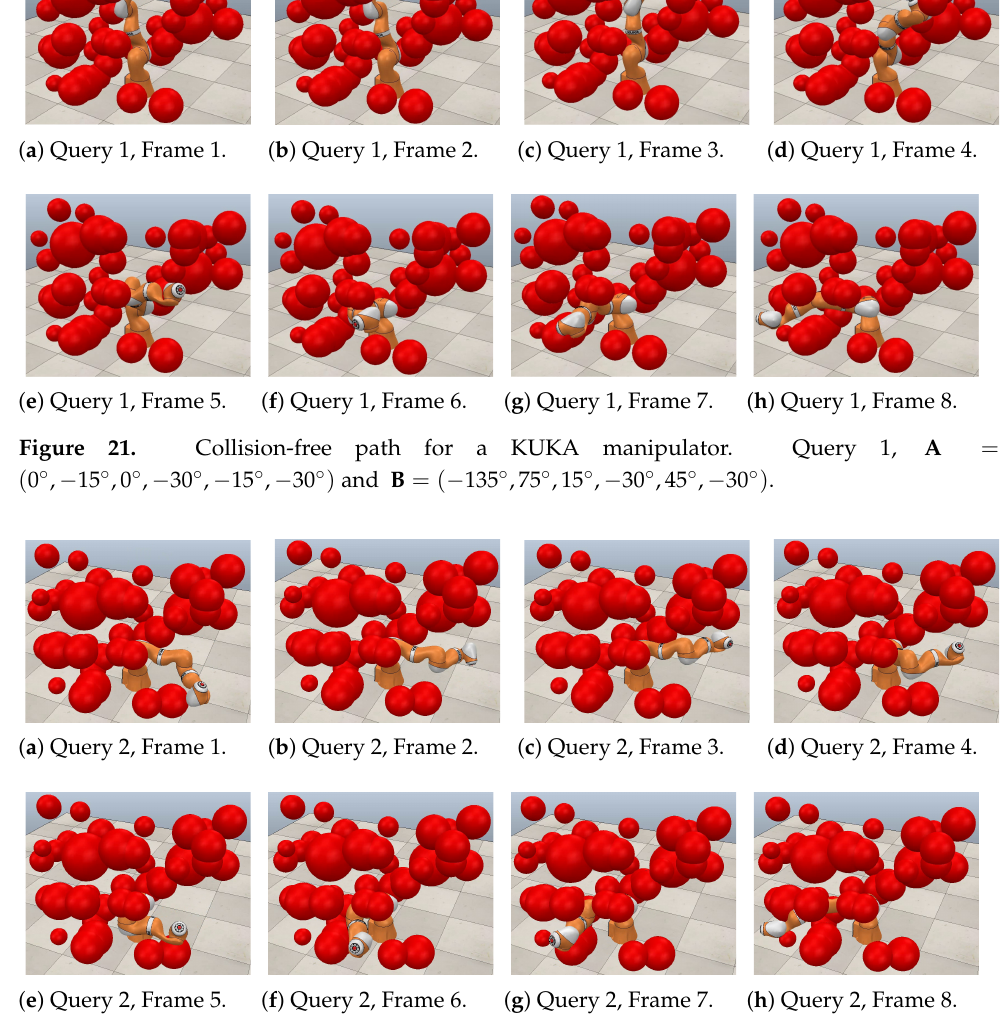
Figure 22. Collision-free path for a KUKA manipulator. Query 2, A = ( 0 ◦ ,90 ◦ ,90 ◦ ,60 ◦ ,75 ◦ ,90 ◦ ) and B = ( − 135 ◦ ,75 ◦ ,15 ◦ , − 30 ◦ ,45 ◦ , − 30 ◦ )